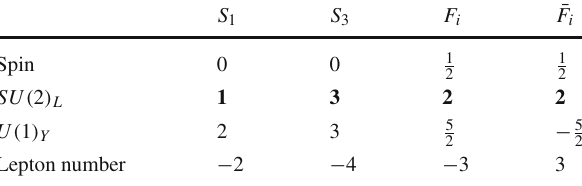
( h ) = 0, the lightest BSM particle cannot decay. The ee ij ) ( h ee ij coupling therefore controls the decay lifetime of the lightest BSM particle. We must stress that the limit ( h ee ) ij = 0 is not allowed phenomenologically, since it would lead to a charged stable relic excluded by cosmology.